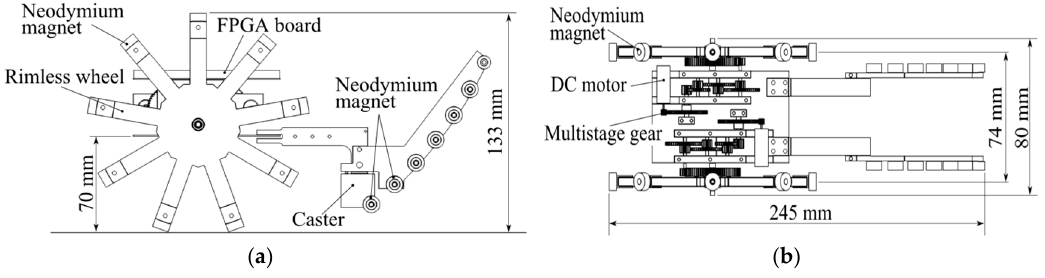
Figure 3. Bridge inspection robot (BIREM 3rd).